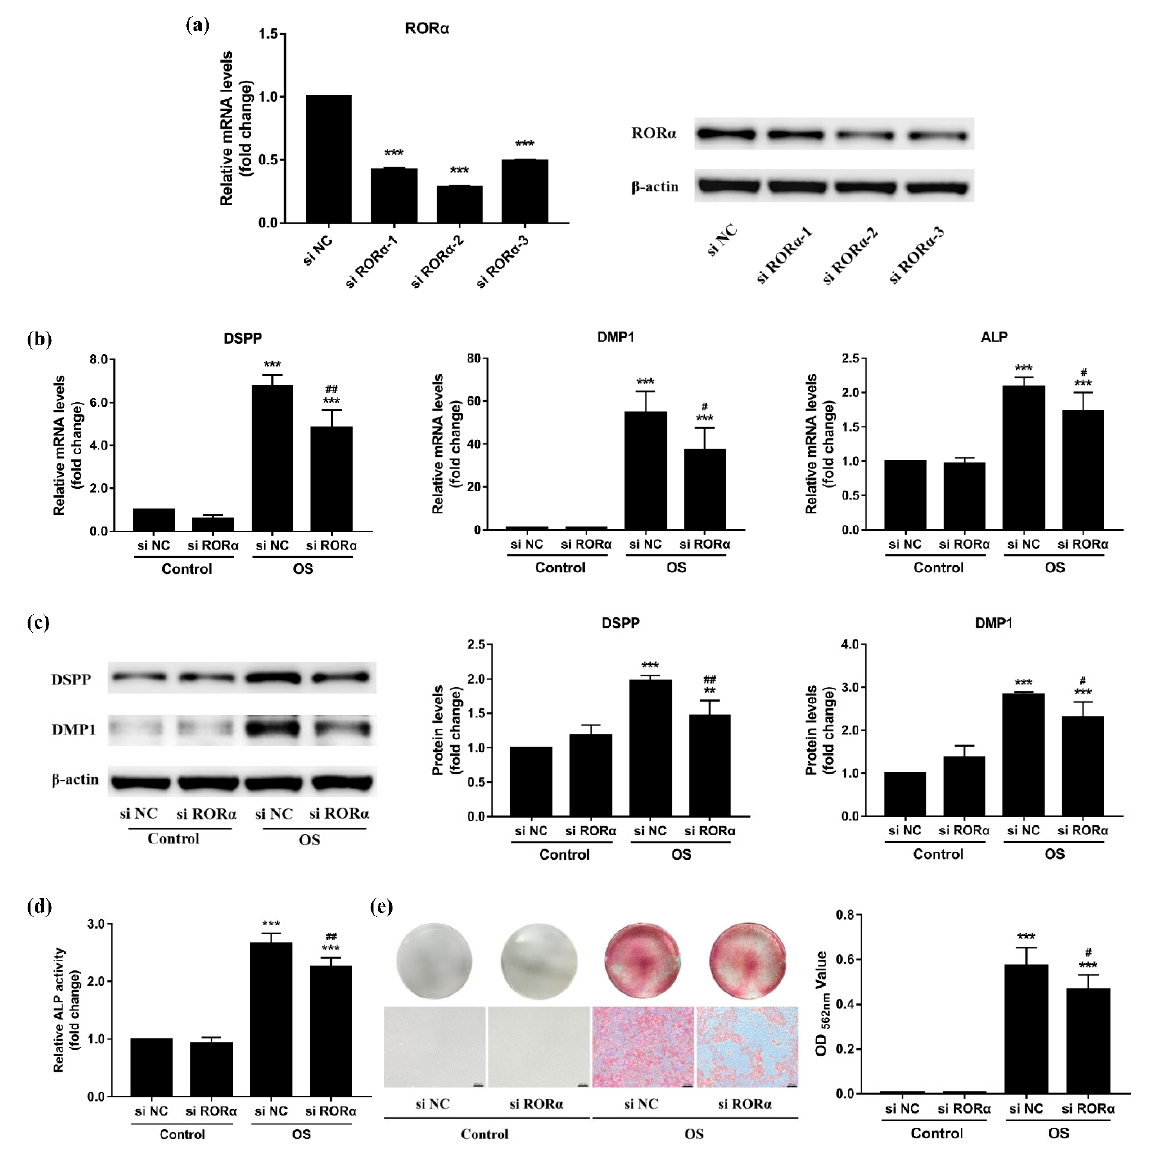
Figure 5. Effect of retinoid acid receptor-related orphan receptor α (ROR α ) knockdown on odontoblastic differentiation of rat dental papilla cells (rDPCs). rDPCs were transfected with small interfering (si) ROR α or si negative control (NC) for 8 h and then cultured in control or odontogenic induction (OS) medium for 3 or 7 days. ( a ) The knockdown efficiency of ROR α was examined by quantitative reverse transcription polymerase chain reaction (qRT-PCR) and western blotting; ( b ) The mRNA levels of dentin sialophosphoprotein (DSPP), dentin matrix protein 1 (DMP1), and alkaline phosphatase (ALP) were measured by qRT-PCR after 3-day induction. Glyceraldehyde-3-phosphate dehydrogenase (GAPDH) was used as the internal control; ( c ) The protein levels of DSPP and DMP1 were detected by western blotting after 7-day induction and normalised to β -actin levels; ( d ) ALP activity was analysed after 7 days of odontogenic induction. ( e ) The formation of mineralized nodules was assessed by alizarin red staining at day 7. Scale bar: 100 µ m. All data are presented as the mean ± SD ( n = 3). ** p < 0.01, *** p < 0.001 vs. si NC or Control-si NC group, # p < 0.05, ## p < 0.01 vs. OS-si NC